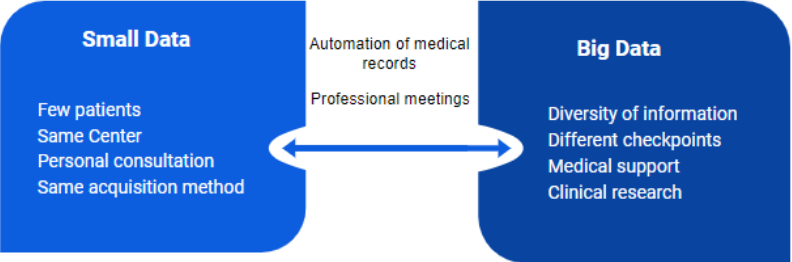
Figure 14. Details of the intersection between small and big data in medicine